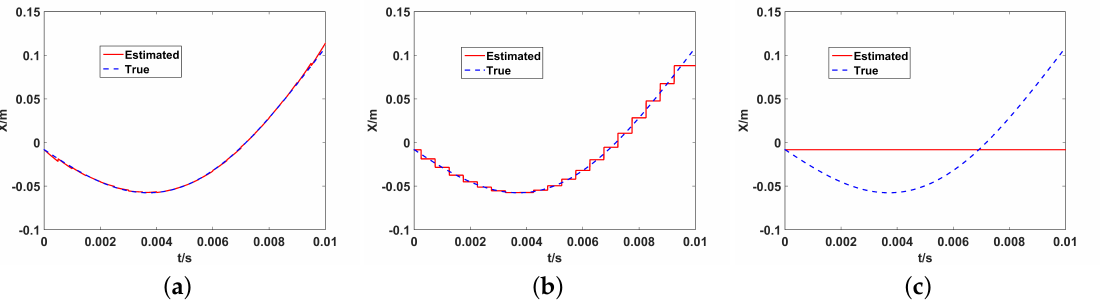
Figure 9. The estimated and the real trajectory of the translation along the X t . ( a ) UPIM; ( b ) DPDIM; ( c )